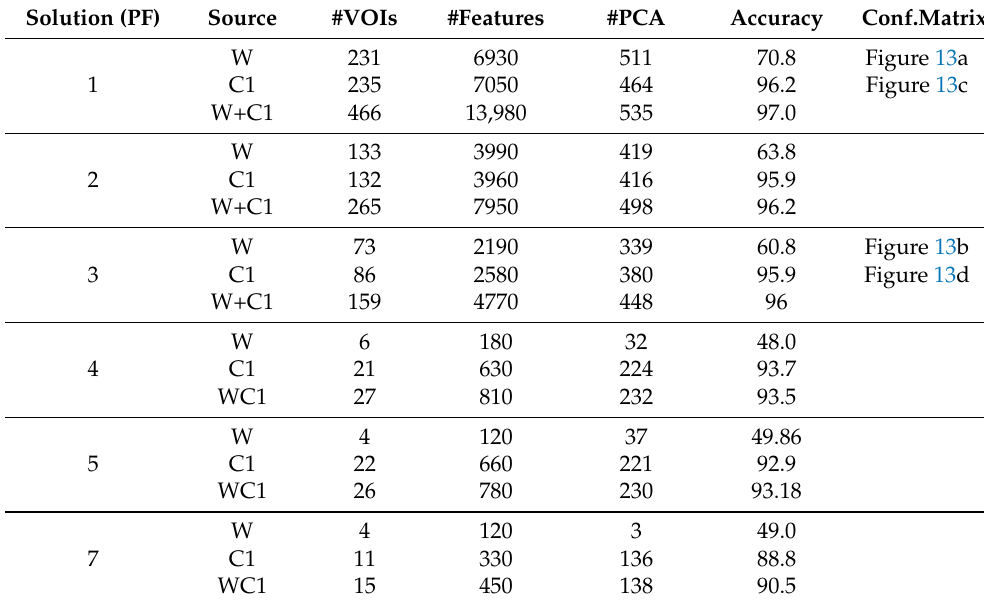
Table 5. Test results for several solutions of the Pareto front. Details of the number of VOIs, number of features and components of the PCA for W,C1 and W+C1